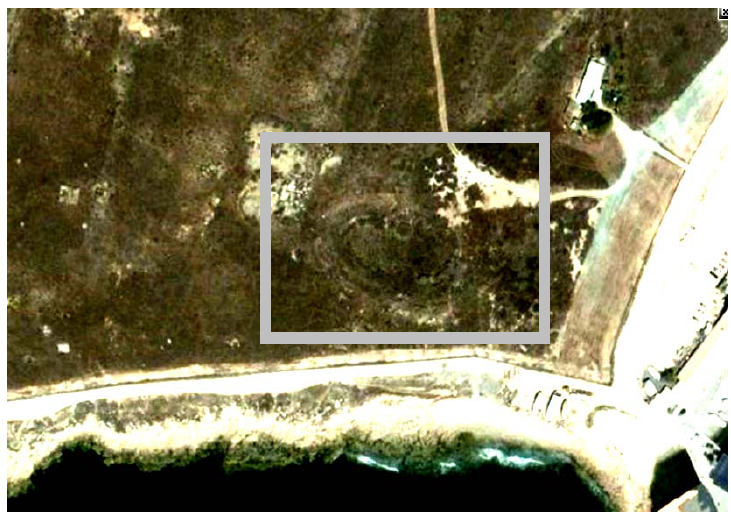
Figure 5. Crop mark at the Nea Paphos archaeological